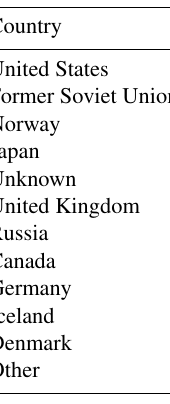
Table 2. Percentage of casts by country.